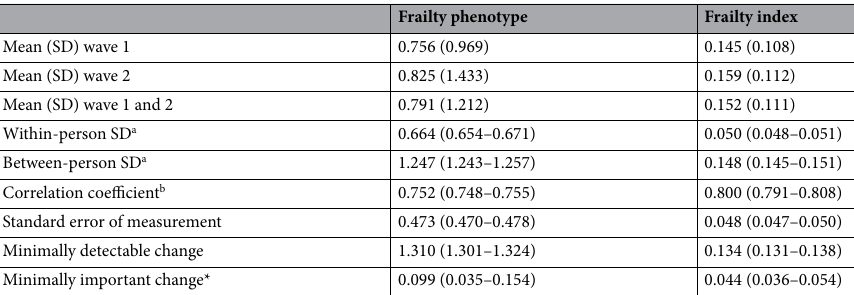
Table 3. Within-person variability in the frailty phenotype and frailty index. a Within- and between-person variance was calculated using the one way analysis of variance of method 24 . b Correlation coefficients are Kendall’s W and Lin’s concordance correlation coefficient for FP and FI, respectively. *See Supplementary Table S6 for more detail on how MIC was